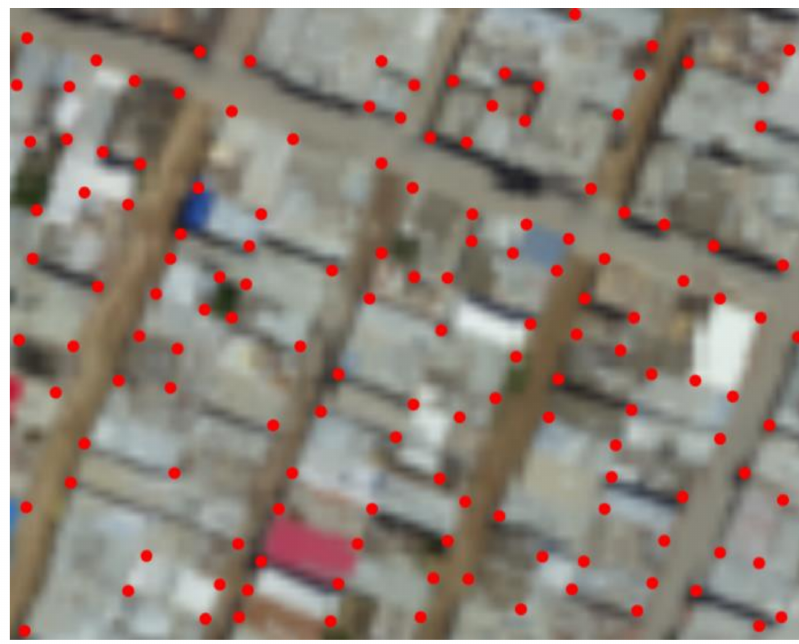
Figure 5. Detected roof edge